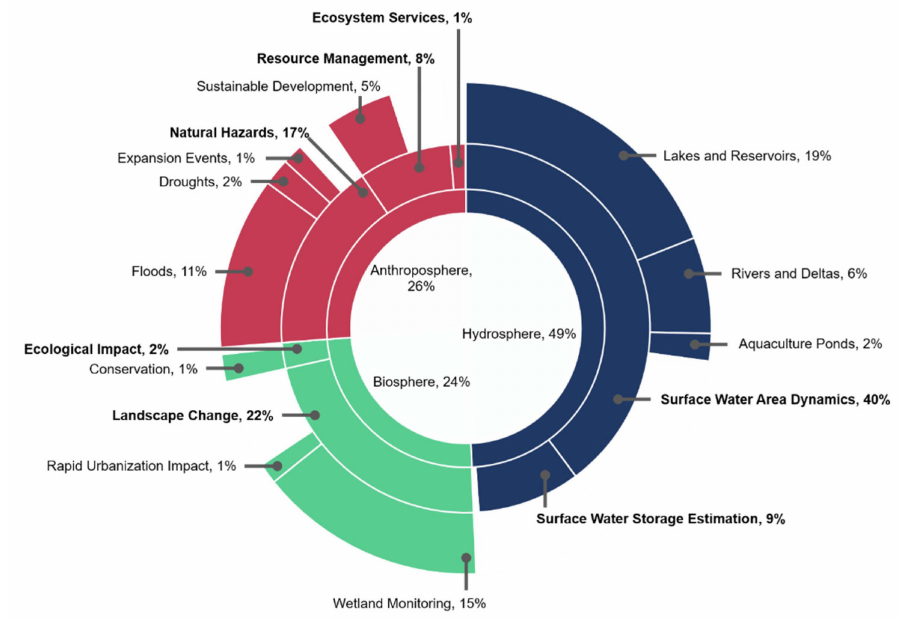
Figure 9. Detailed summary of investigated applications of n = 221 publications. Application fields are color-coded: Hydrosphere – blue, Biosphere – green, Anthroposphere – red. Most works are concerned with several of the given application topics. However, only the main focus is considered for this figure. Due to a rounding error, the numbers do not add up exactly. The closeness of spheres mimics the relatedness of focus topics. Those works that are not specified into further subgroups have a focus too broad to narrow it down further. As an example: 49% of included works have their primary focus on hydrosphere. A subset of 40% of all included works concentrates on surface water area dynamics. Narrowing it down further, a subset of 19% of included publications concentrates on lakes and